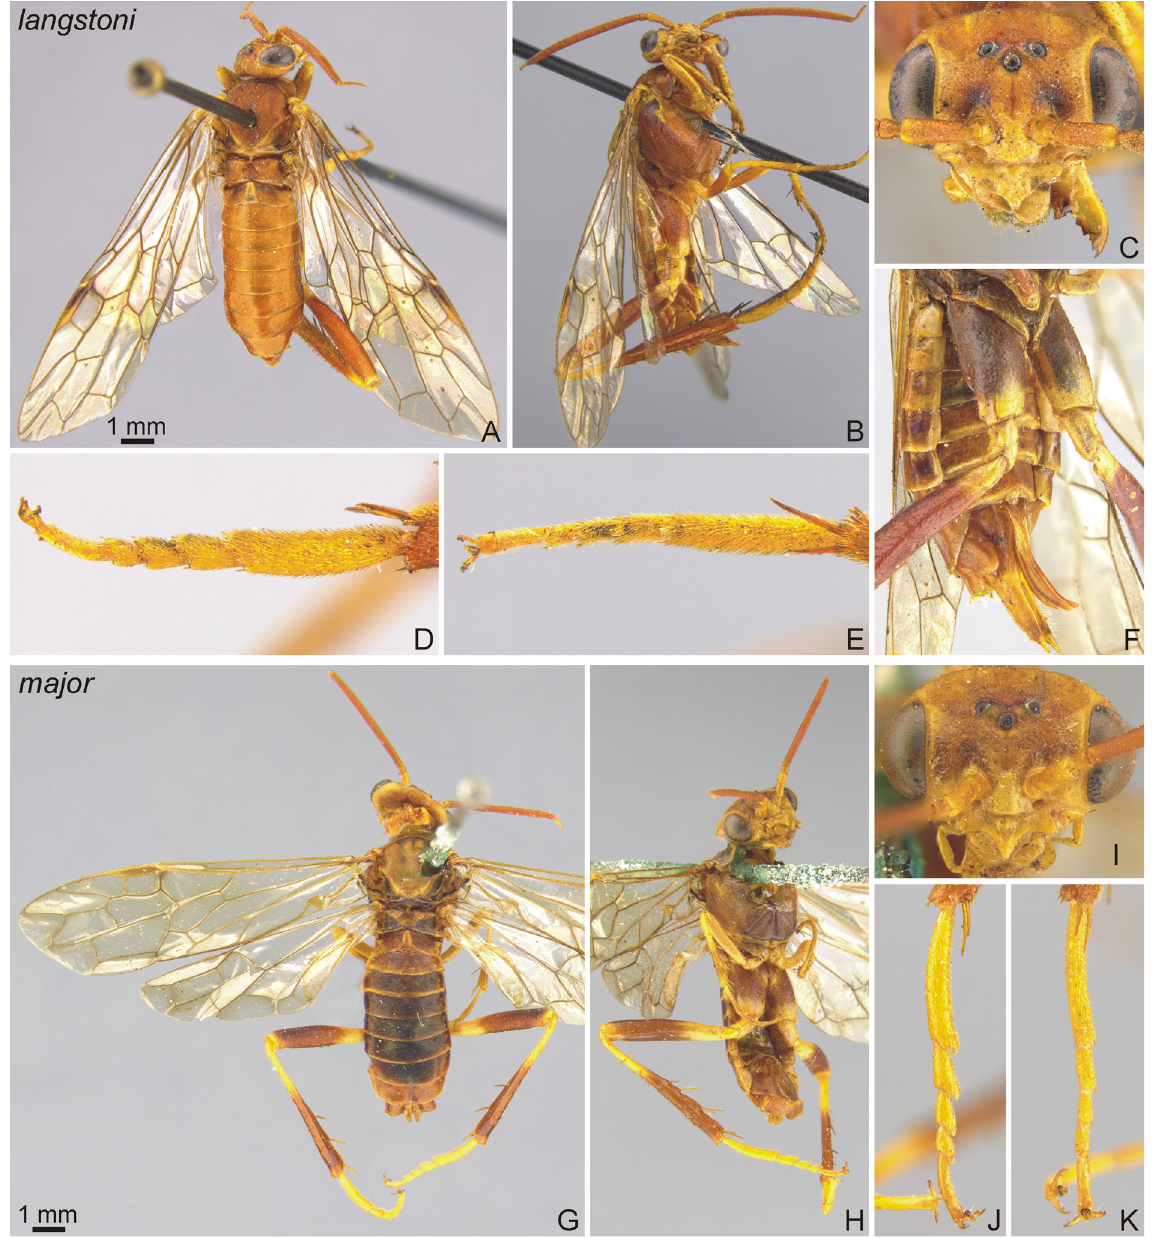
Fig. 7. A–F . Megaxyela langstoni Ross, 1936, ♀ (A–C = holotype, DEI-GISHym 30821, INHS; D–F = 30822, USNM). G–K . M. major (Cresson, 1880), ♂, paratype (30823, ANSP). A–B . ♀, holotype, habitus dorsal/lateroventral. C . ♀, holotype, head frontal. D–E . ♀, metatarsus, lateral/ventral. F . ♀, abdomen lateroventral. G–H . Habitus dorsal/lateroventral. I . Head frontal. J–K . Metatarsus lateral/